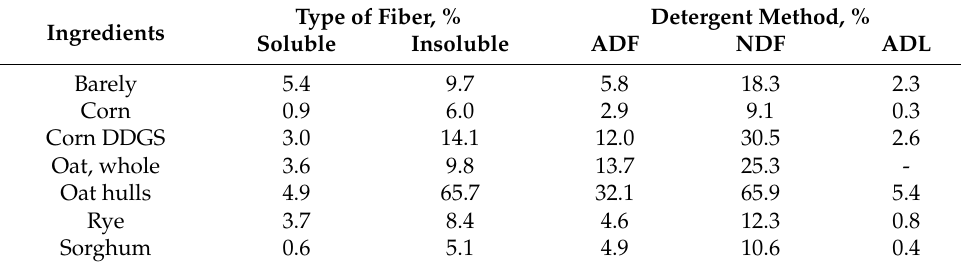
Table 2. Fiber composition of feed ingredients used in pig diets a